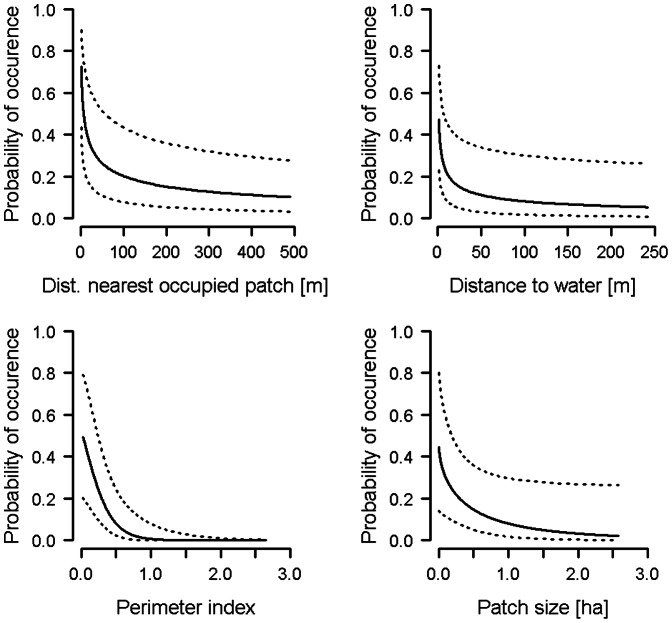
Patch occupancy in the large gold grasshopper.Probability of occurrence of the large gold grasshopper in a patch in relation to distance to the nearest occupied patch, distance to water, patch size and the perimeter index. Plots show predicted values (solid lines) and 95% CI (dashed lines) from the model. Noccupied  = 71, nunoccupied  = 281.